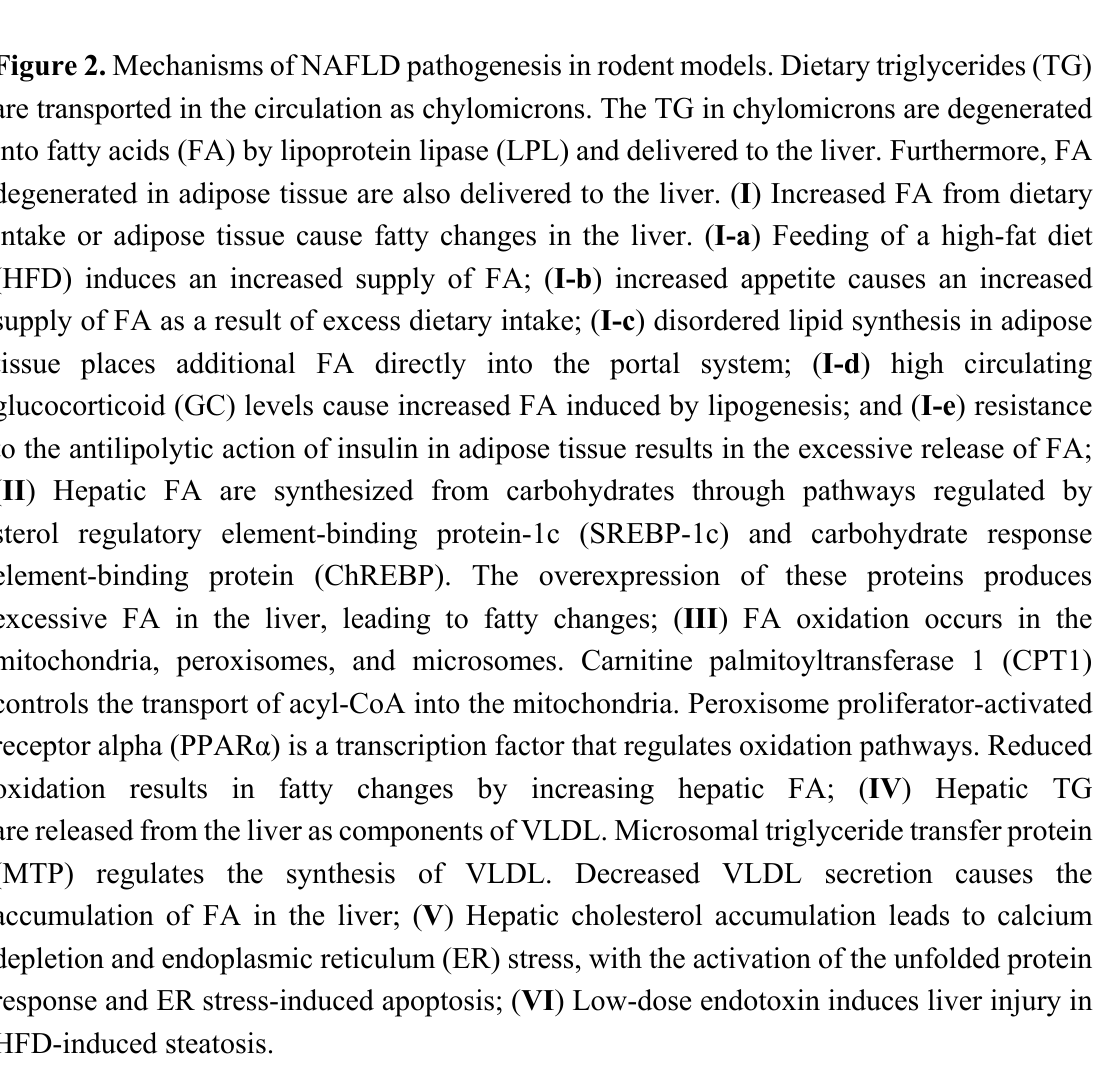
Figure 2. Mechanisms of NAFLD pathogenesis in rodent models. Dietary triglycerides (TG) are transported in the circulation as chylomicrons. The TG in chylomicrons are degenerated into fatty acids (FA) by lipoprotein lipase (LPL) and delivered to the liver. Furthermore,